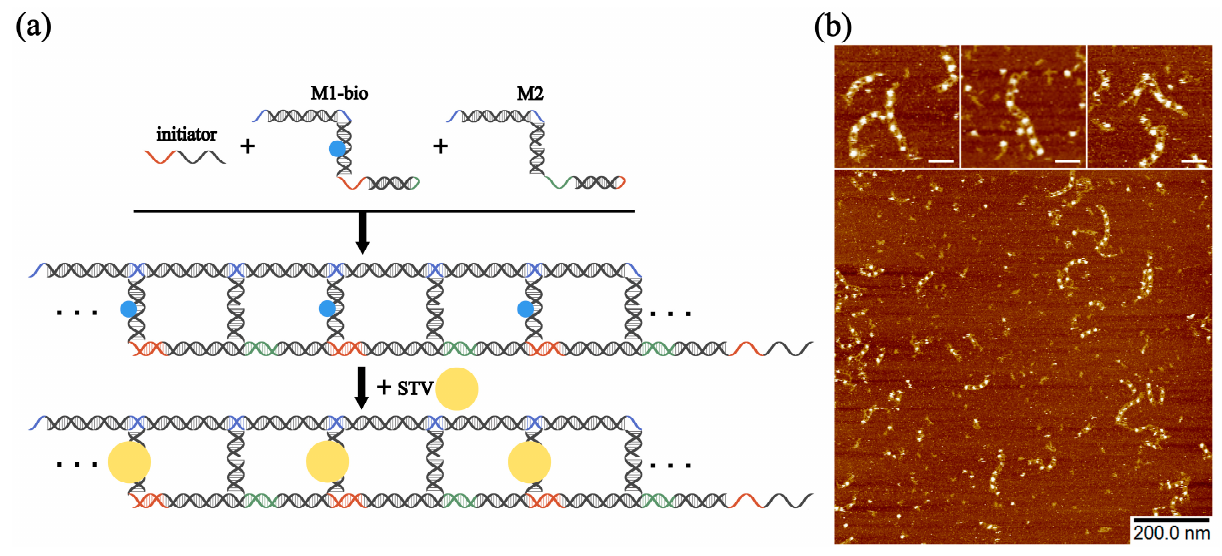
Figure 6. ( a ) Simple self-assembly schematic illustrations of motif M1-bio, M2, and initiator. Motif M1-bio is modified with biotin first (blue dots represent biotin) and then labeled with streptavidin (STV) (yellow spheres represent STV) after assembly. ( b ) AFM images of the STV-decorated nanoladders. Three close-up views of the AFM images are shown. Scale bar: 20 nm. [M1-bio] = [M2] = 500 nM, [initiator] = 50 nM. The final concentration of the assembled nanoladders is 500 nM, and the concentration of STV is 5 μ M.